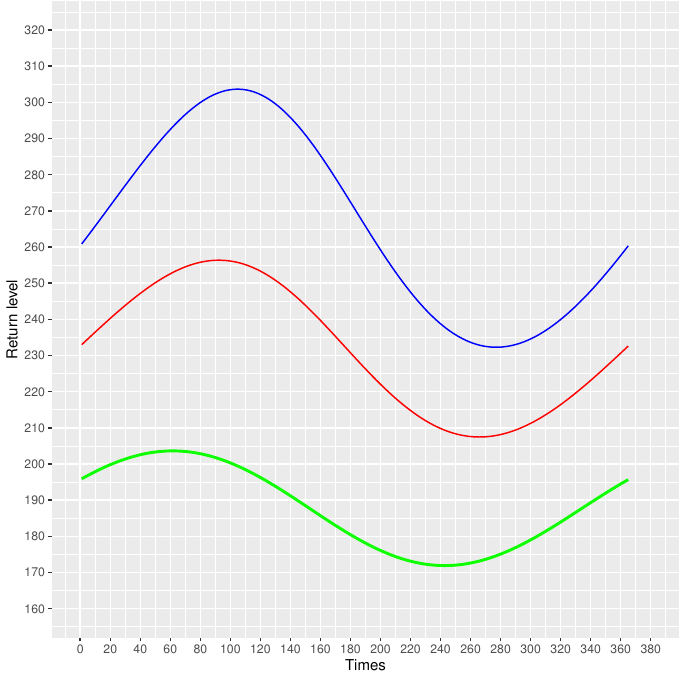
Figure 19. Return levels expected every 10, 50 and 100 years for Patuxent river daily flow. Green: expected return every 10 years; red: expected return every 50 years; blue: expected return every 100